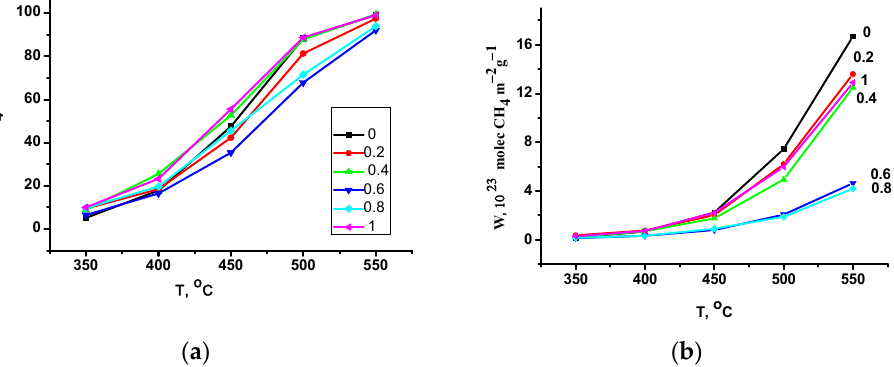
Figure 6. Temperature dependence of methane conversion ( a ) and methane oxidation rate ( b ) for LaMn 1 − x Fe x O 3 perovskites.